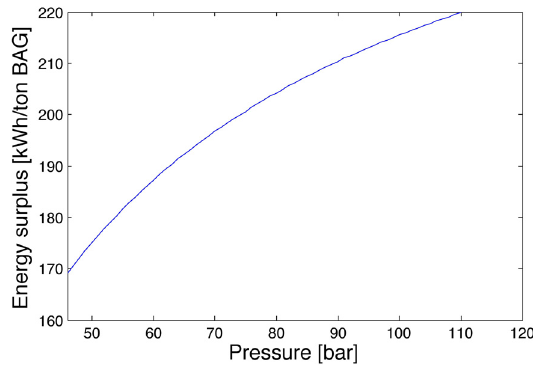
Figure 13. Effect of new cycle boiler’s pressure on energy surplus